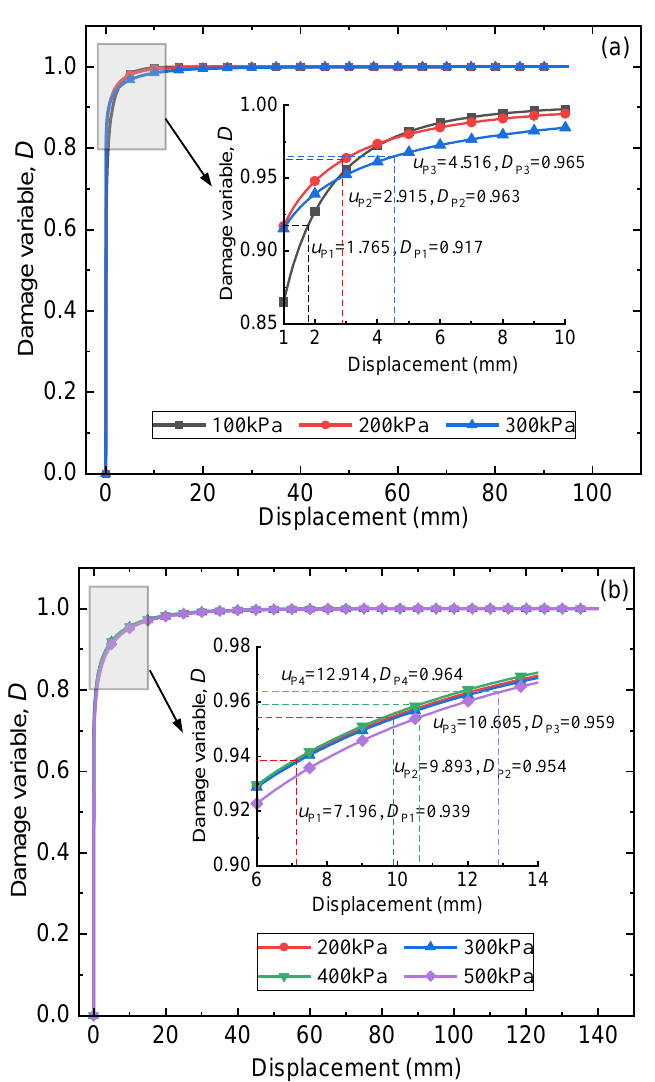
Figure 13. Evolution curves of damage variable based on Gamma distribution fitting results. ( a ) Damage evolution curves of type A; ( b ) damage evolution curves of type B.